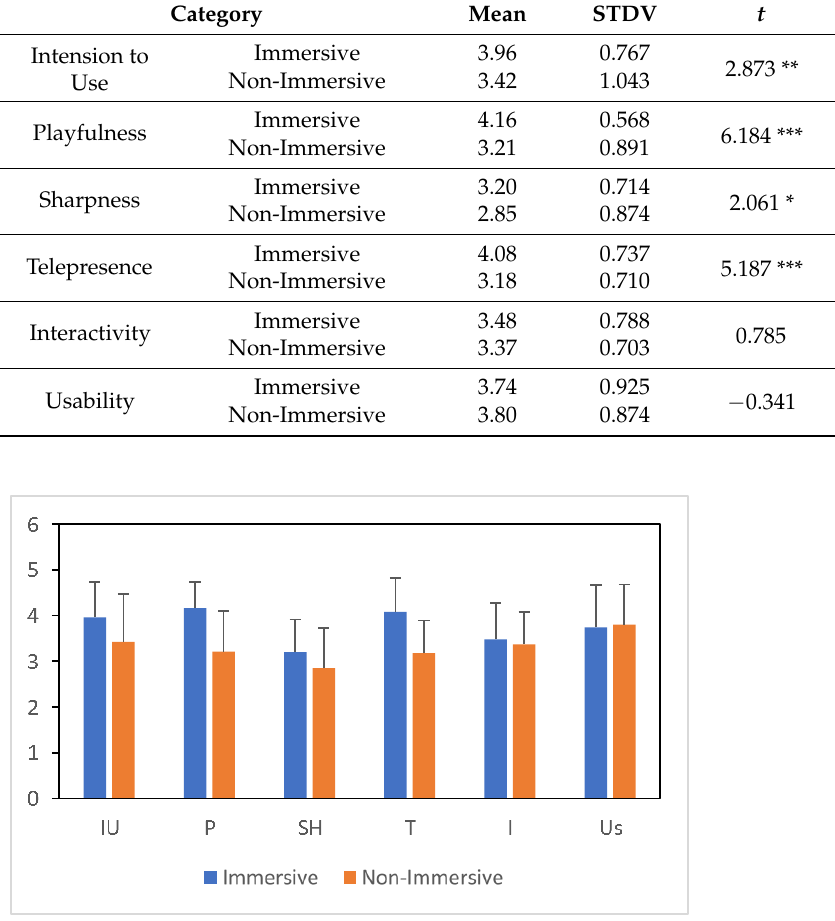
Figure 3. Comparing the